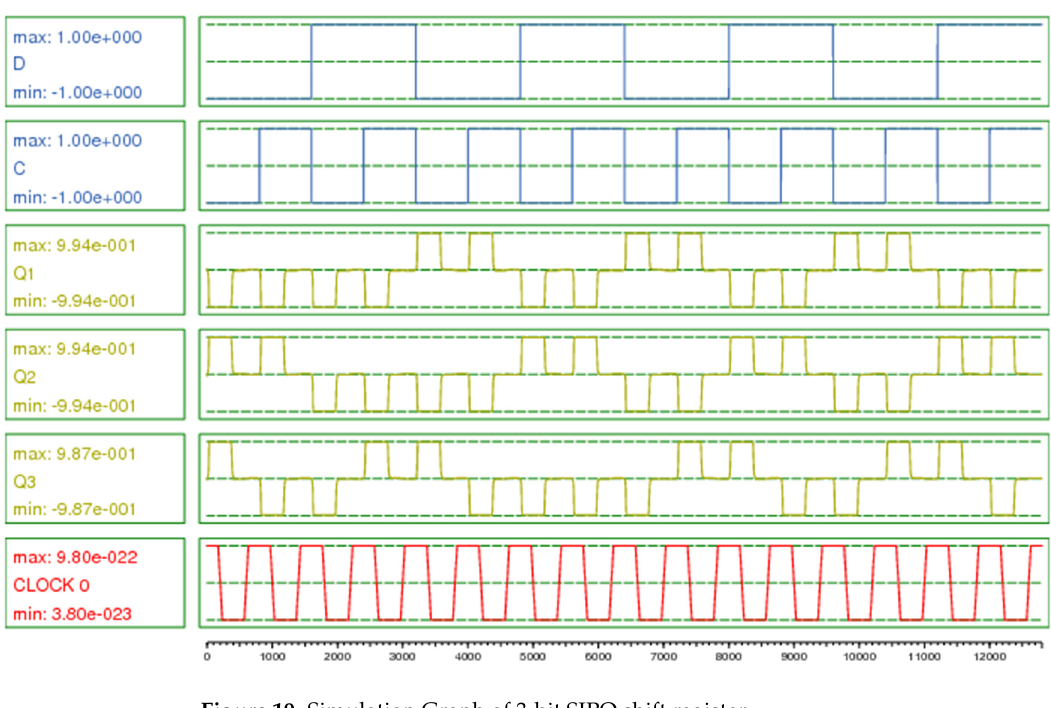
Figure 19. Simulation Graph of 3-bit SIPO shift register.